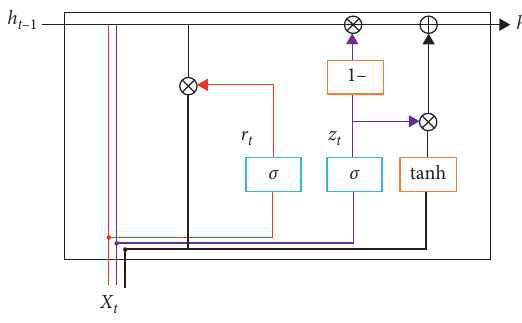
Figure 2: The basic unit structure of